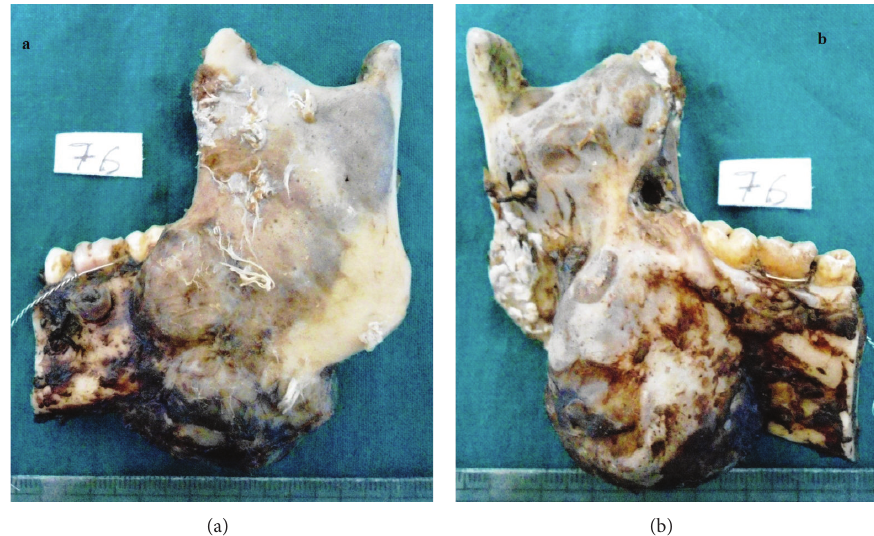
Figure 5: Resected mandible sent for histopathologic examination, (a) lateral surface, and (b) medial surface of the mandible.